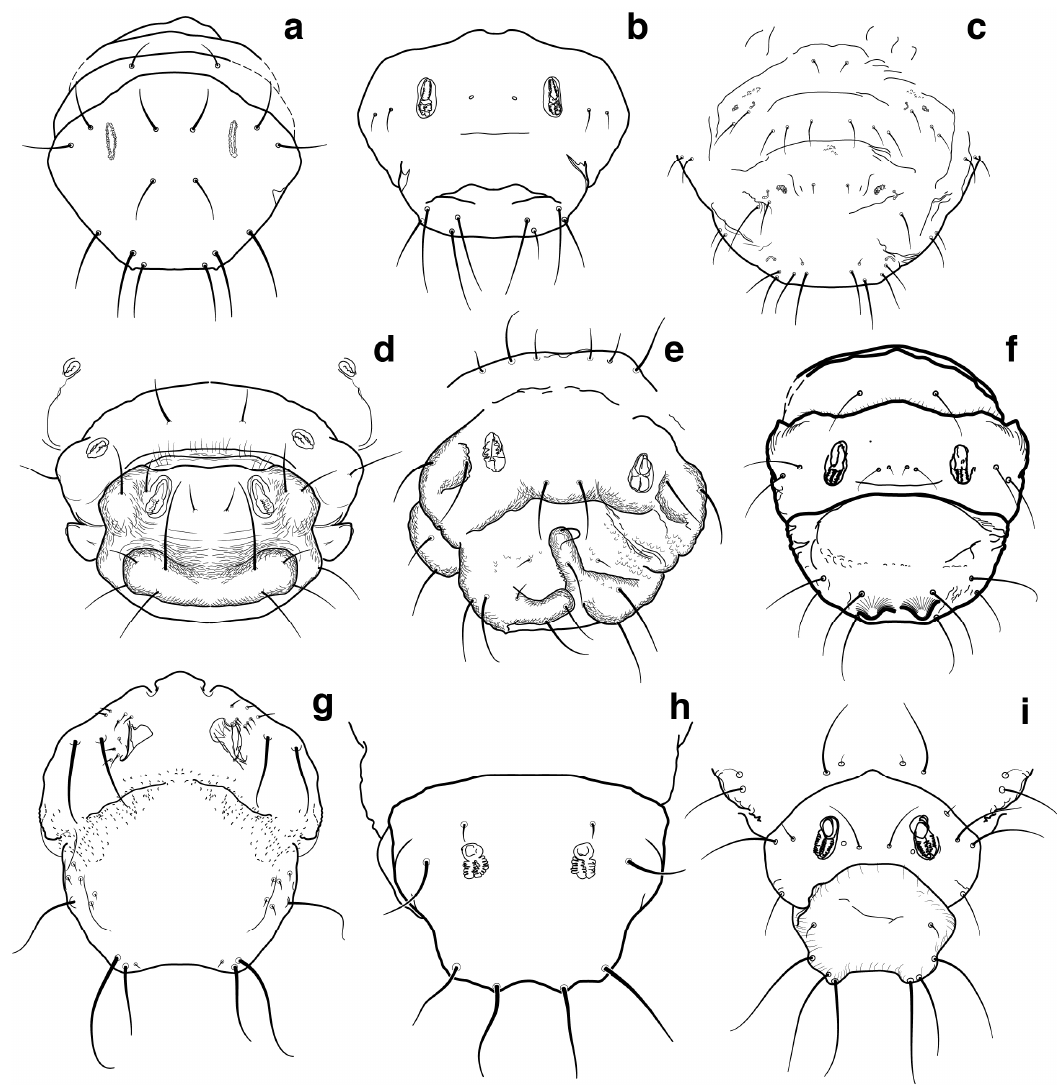
Figure 14. Segments VIII and IX, larva, caudal view: ( a ) Cosmopolites ; ( b ) Metamasius ; ( c ) Myocalandra ; ( d ) Nassophasis ; ( e ) Phacecorynes ; ( f ) Rhodobaenus ; ( g ) Rhynchophorus ; ( h ) Stenommatus ; and ( i ) Trochorhopalus .